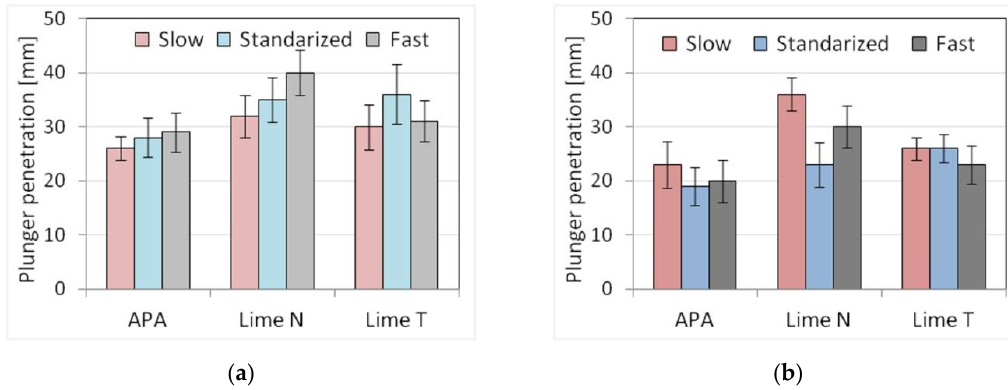
Figure 13. Influence of the mixing intensity on the consistency tested by plunger penetration method of ( a ) plaster, ( b ) masonry mortars.